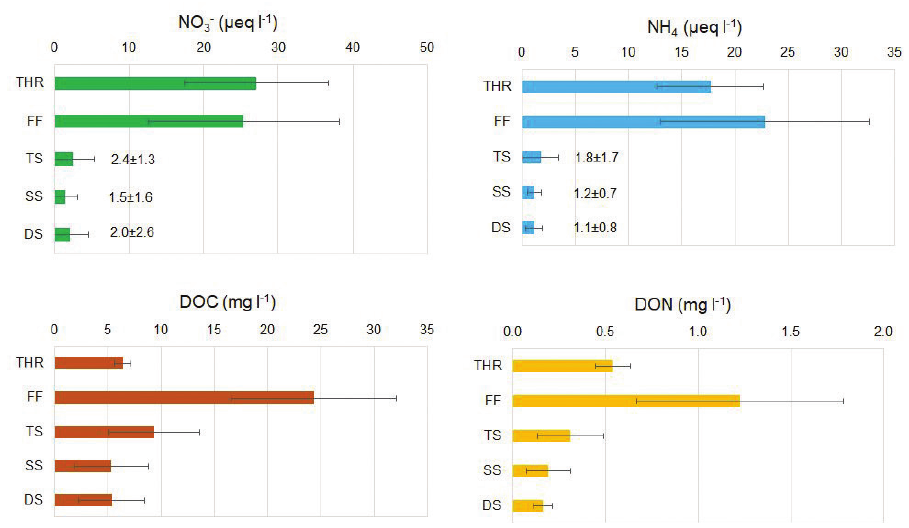
Figure 2. VWM concentrations of nitrate, ammonia, DOC and DON in water samples collected in dif- ferent compartments at Val Masino site. Error bars represent the standard deviation. THR = throughfall depositions; FF = forest floor leachate; TS (topsoil) = soil solution at 15 cm depth; SS (subsoil) = soil solution at 40 cm depth; DS (deep soil) = soil solution at 70 cm